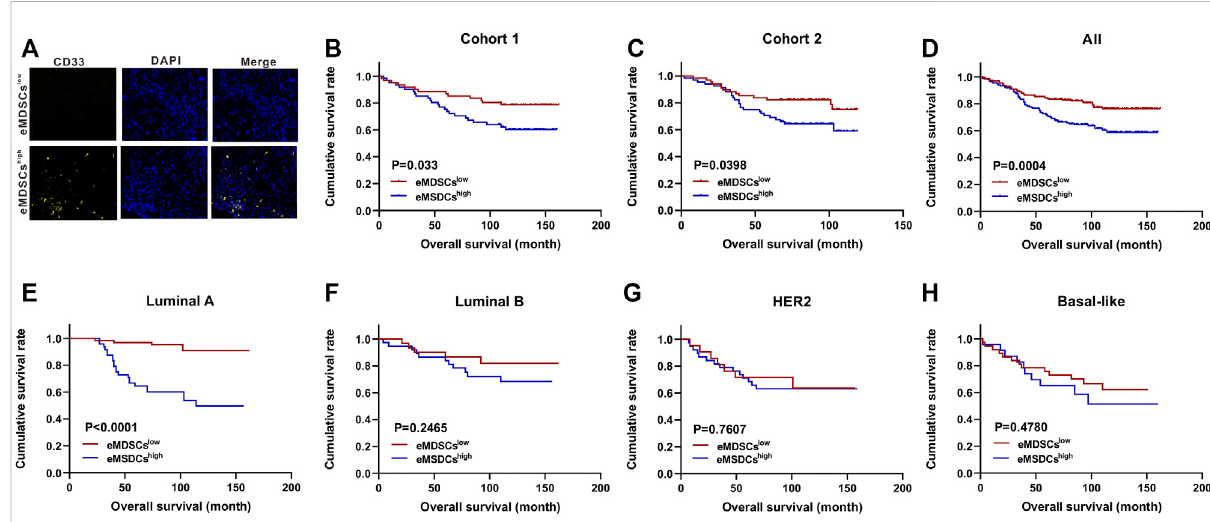
FIGURE 2 Highly-in fi ltratedeMDSCsaresigni fi cantly correlatedwithpoorprognosisinbreastcancerpatients (A) MultispectralIFstaininganalysisshowed the in fi ltration of CD33 + cells in tumor sections from 280 cases of breast cancer patients. (B – H) Kaplan-Meier survival analysis of overall survival between eMDSCs high and eMDSCs low groups among 4 different subtypes of 280 cases of breast cancer